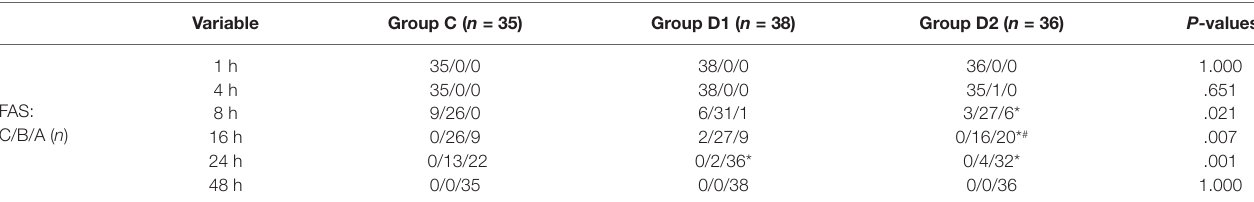
TABLE 5 | FAS during 48 h after surgery in the three